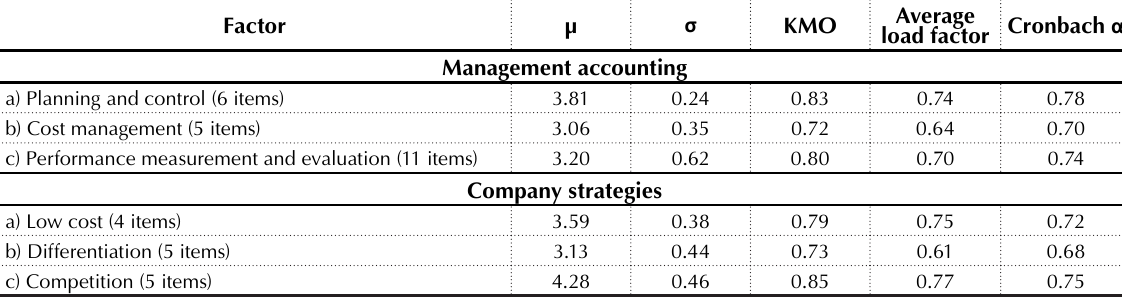
Table 1. Factor analysis and reliability values of